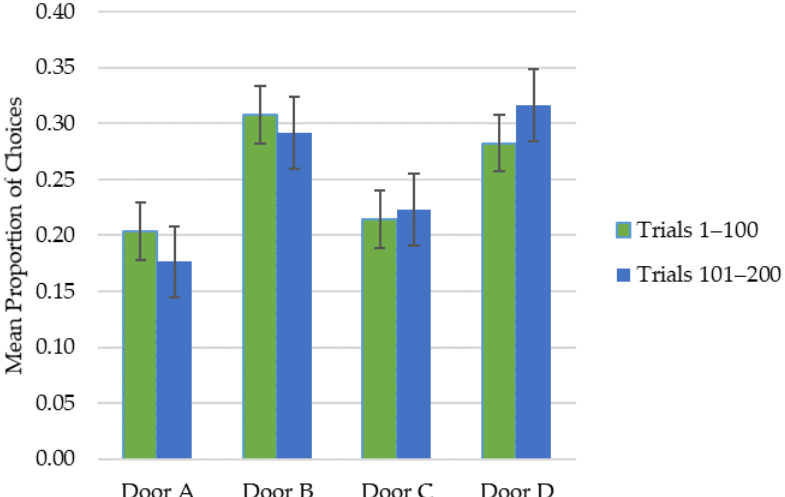
Figure 2. Mean proportion of choices by door for each 100-trial epoch in the whole sample. The differences between Trials 1–100 and Trials 101–200 are at significance p level < 0.001.